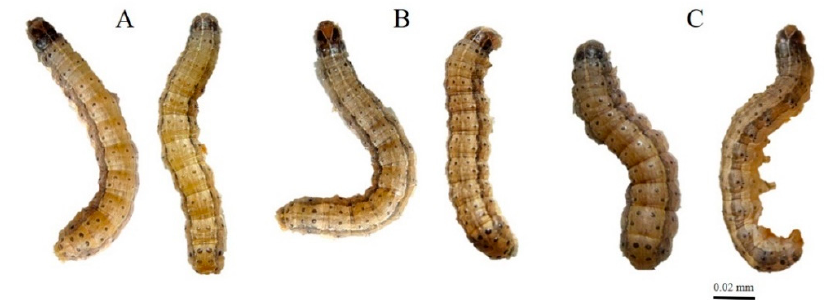
emergence. emergence. emergence.